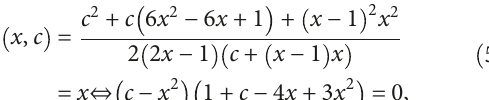
Figure 2: Dynamical planes of OM 10 on p x = x 2 − c